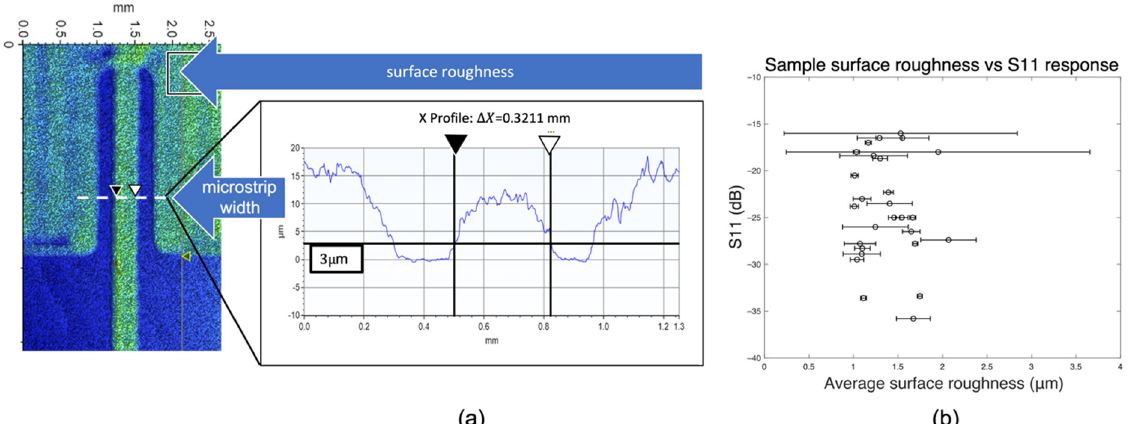
Figure 1. Feature measurement: ( a ) Graph showing the x-profile of an antenna along the dashed line of the profilometer image, with black and white triangular indicators marking the point of 3 μ m height (skin depth) on either side of the microstrip. ∆𝑋 measures the space between the markers and is taken as the microstrip width: 321 μ m for this cross-section; ( b ) Plot showing average surface roughness compared with respective antenna S11 response at 8 GHz. Surface roughness was measured as Sq, or root mean square height, on the antenna patch using the same profilometry software as in ( a ). We expect no change to the trends calculated in this work if we instead used arithmetical mean roughness Ra. Results in ( b ) show no noticeable correlation between roughness and S11 in this dataset.